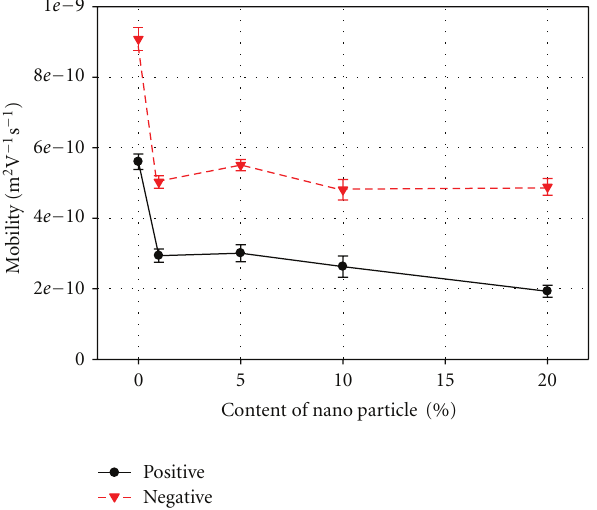
Figure 10: Charge mobility of positive and negative charge pulses in pure epoxy resin and epoxy-based nanocomposites (90% confidence